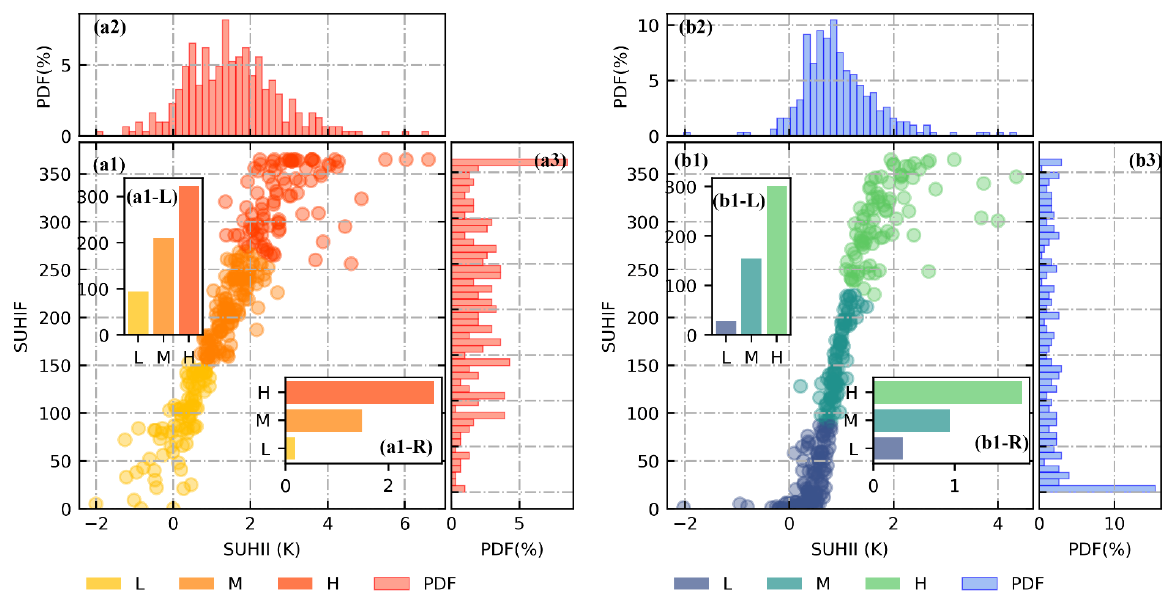
Figure 7. Relationship between SUHII and SUHIF at daytime ( a ) and nighttime ( b ). The scatter plots show their relationship, with color representation of three categories, namely the low (L), medium (M), and high (H) patterns. To clearly show the characteristics of these three categories, the bar charts show the average of SUHII ( a1-R , b1-R ) and SUHIF ( a1-L , b1-L ). The histograms represent the PDF of SUHII ( a2 , b2 ) and SUHIF ( a3 , b3 ).